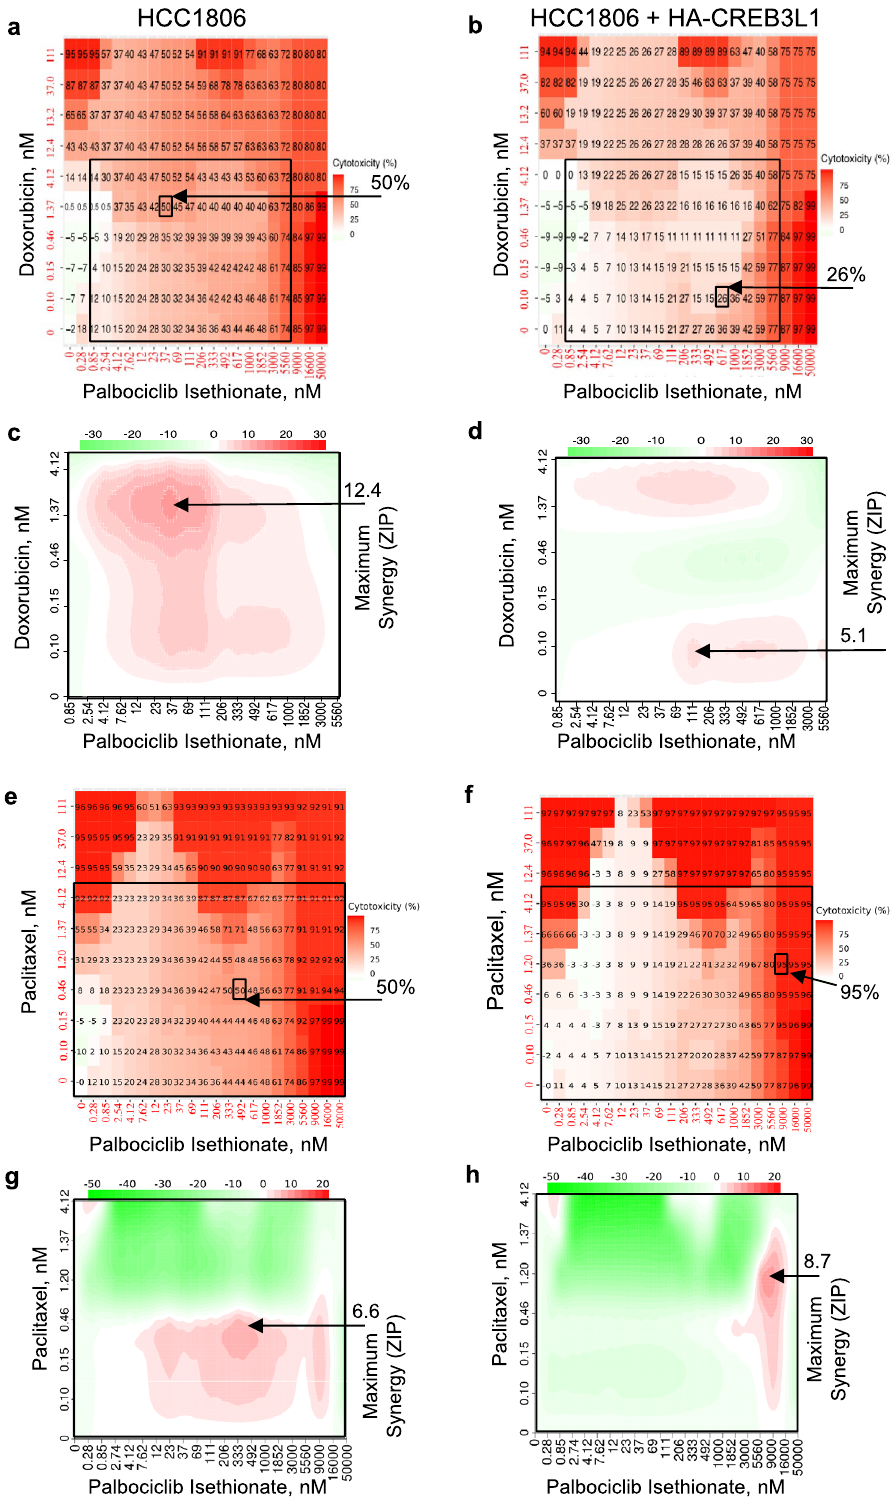
Figure 4. Assessing possible drug synergy between palbociclib isethionate and either doxorubicin ( a-d ) or paclitaxel ( e–h ). Cell viability ( a, b, e, f ) was measured after 4 days of drug treatment over a range of drug concentrations for HCC1806 ( a, c, e, g ) and HCC1806 + HA-CREB3L1 ( b, d, f, h ) cells. Palbociclib Isethionate EC 50 for HCC1806 = 500 nM; 1:3 serial dilutions (0–9 mM). Doxorubicin EC 50 for HCC1806 = 13 nM; 1:3 serial dilutions (0–111 nM). Paclitaxel EC 50 for HCC1806 = 1.2 nM; 1:3 serial dilutions (0–111 nM). A zero- interaction potency score (ZIP; c, d, g, h ) was calculated by the SynergyFinder R-package for each data point to measure possible drug synergy; ZIP > 10 indicates